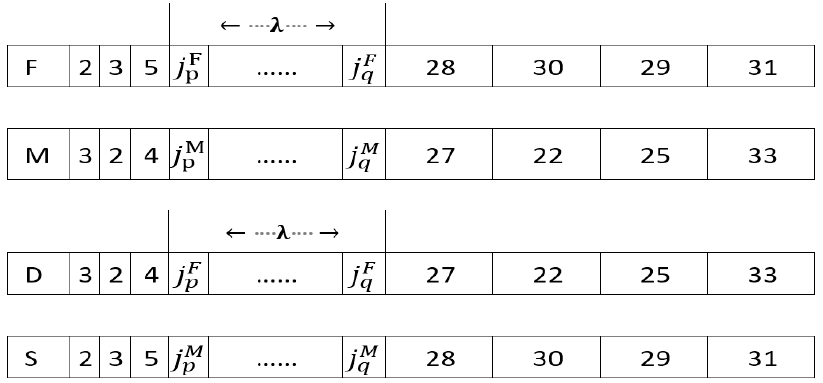
Figure 4. Forbidden time windows crossover operator.